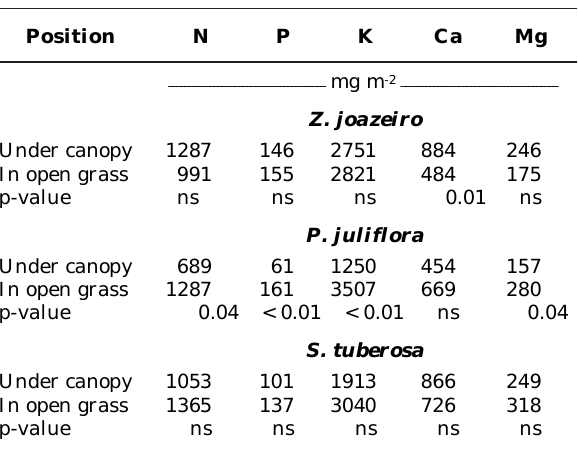
Table 5. Mean values (n = 21) of nutrient stock in the herbaceous layer under the canopy and in open-grass areas of Z. joazeiro , P. juliflora , and S. tuberosa